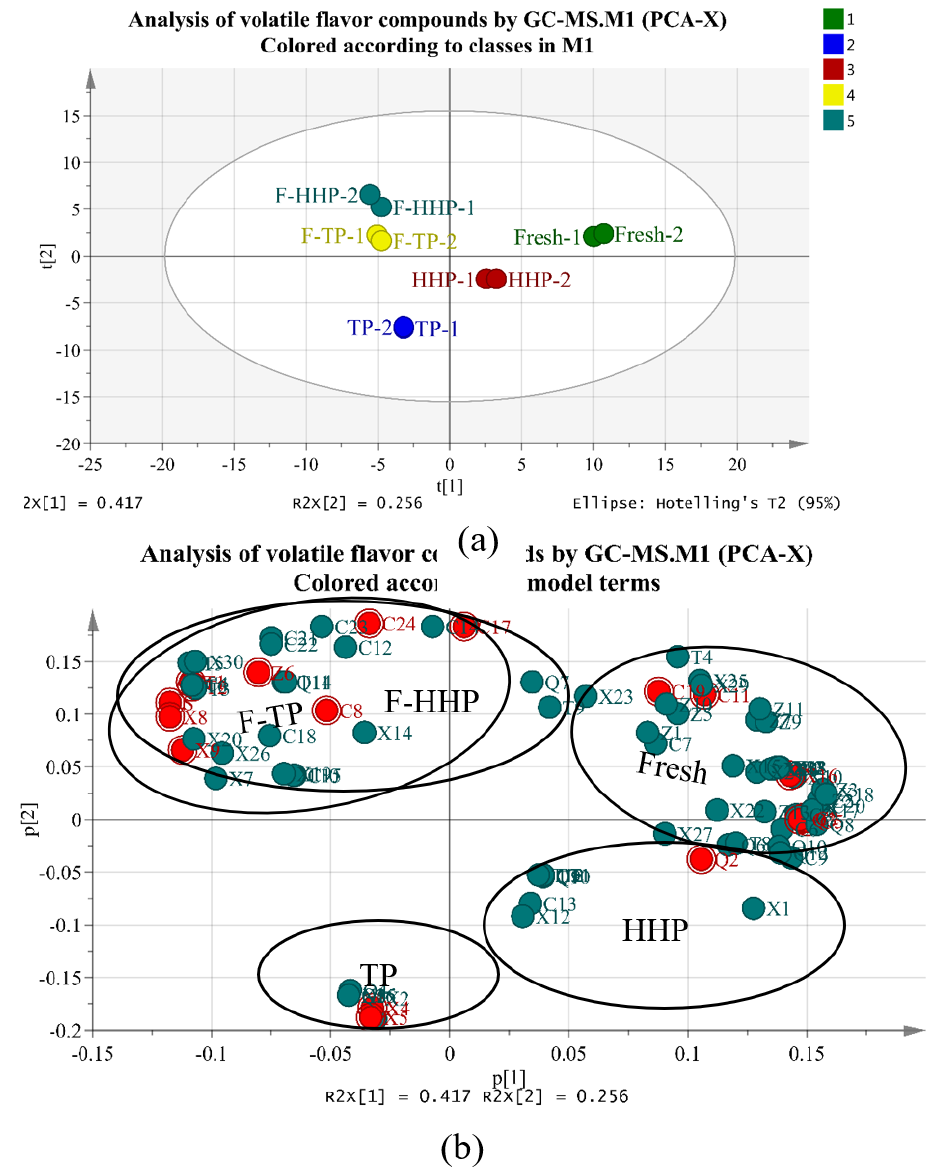
Figure 5. (a) principal component analysis (PCA) score plot and (b) loading plot of volatile flavor components of different treated yacon-litchi-longan (YLL)